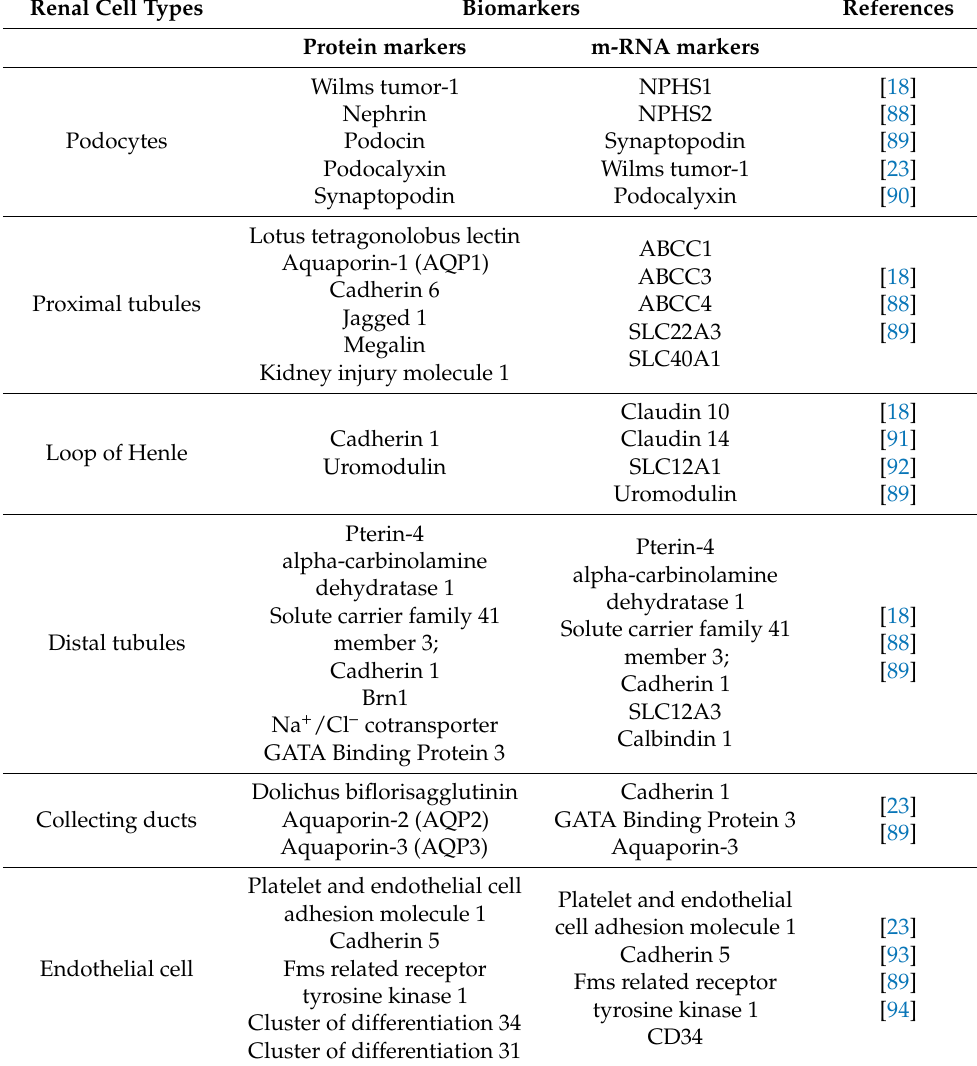
Table 3. Biomarkers of renal